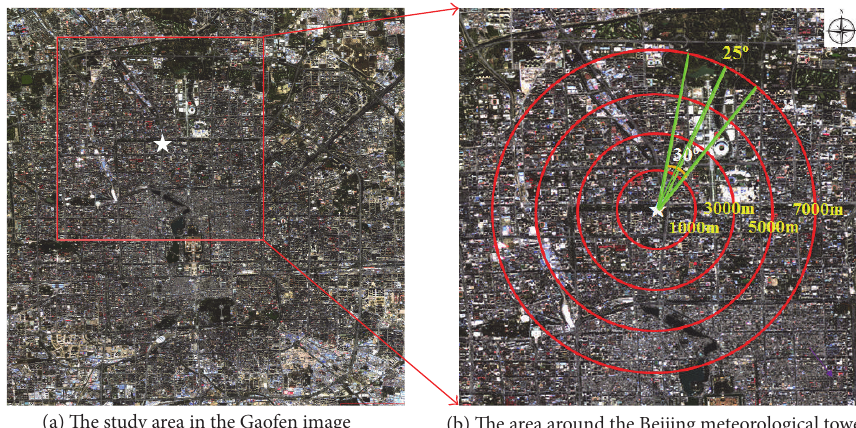
Figure 1: The study area of Beijing city. (a) shows the Gaofen image of Beijing city (8m resolution) on 12 October 2015; (b) shows the area around the Beijing meteorological tower (14km × 14 km), where the white star represents the position of the meteorological tower, the red circles illustrate various dimension settings of the upwind sector, and the green lines intersecting with the red circles represent the upwind sectors with the opening angle of 30 ∘ , the central angle of 25 ∘ , and the various radii of 1000m, 3000 m, 5000 m, and 7000